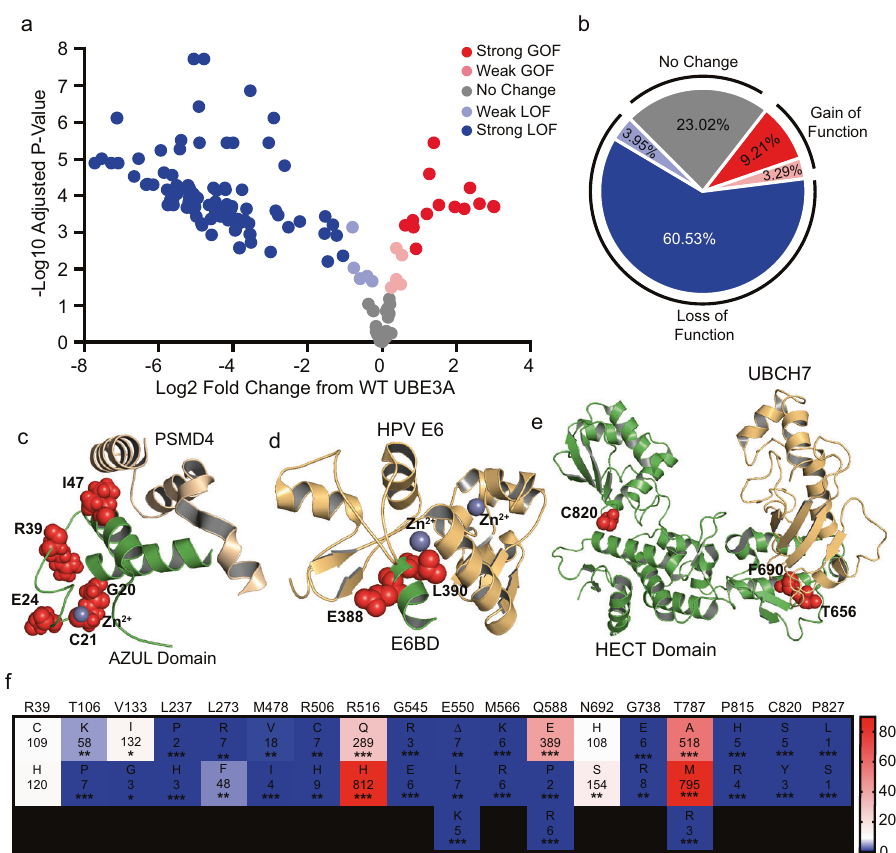
Fig. 2 UBE3A variants encompass a broad landscape of functional effects. a BAR assay screen of 152 UBE3A variants showing benign (gray), weak loss- of-function (light blue), strong loss-of-function (blue), weak gain-of-function (pink), and strong gain-of-function (red) mutations relative to WT UBE3A. Signi fi cance was determined using a One-sample t -test (two-tailed) with Benjamini – Hochberg multiple comparisons correction (FDR = 0.05). Exact numbers of experiments and p -values are provided in Supplementary Data 1. Red, strong gain-of-function; Pink, weak gain-of-function; Gray, no change from WT UBE3A; Light blue, weak loss-of-function; Blue, strong loss-of-function. b Distribution of functional classes for variants tested in our screen. c Solution NMR (PDB: 6U19) of the AZUL domain of UBE3A (green) bound to PSMD4 (gold). Variants tested in our screen are shown in red. d Co-crystal structure (PDB: 4GIZ) of the E6BD domain of UBE3A (green) bound to HPV E6 (gold). Variants tested in our screen are shown in red. e Co-crystal structure (PDB: 1C4Z) of the HECT domain of UBE3A (green) bound to the E2 enzyme UBCH7 (gold). Variants tested in our screen (red) included mutations at the catalytic cysteine (C820) and the E2-binding interface (T656 and F690). f Heat map plot showing BAR assay results from UBE3A sites with multiple variants. Values are normalized to WT UBE3A activity. White shading represents WT UBE3A activity levels, blue shading indicates loss-of- function, and red shading indicates gain-of-function. Scale bar shows the percent change relative to WT UBE3A. Exact numbers of experiments and p -values are provided in Supplementary Data 1, * p < 0.05, ** p < 0.005, p < 0.0005, One-sample t -test (two-tailed) with Benjamini – Hochberg multiple comparisons correction (FDR =